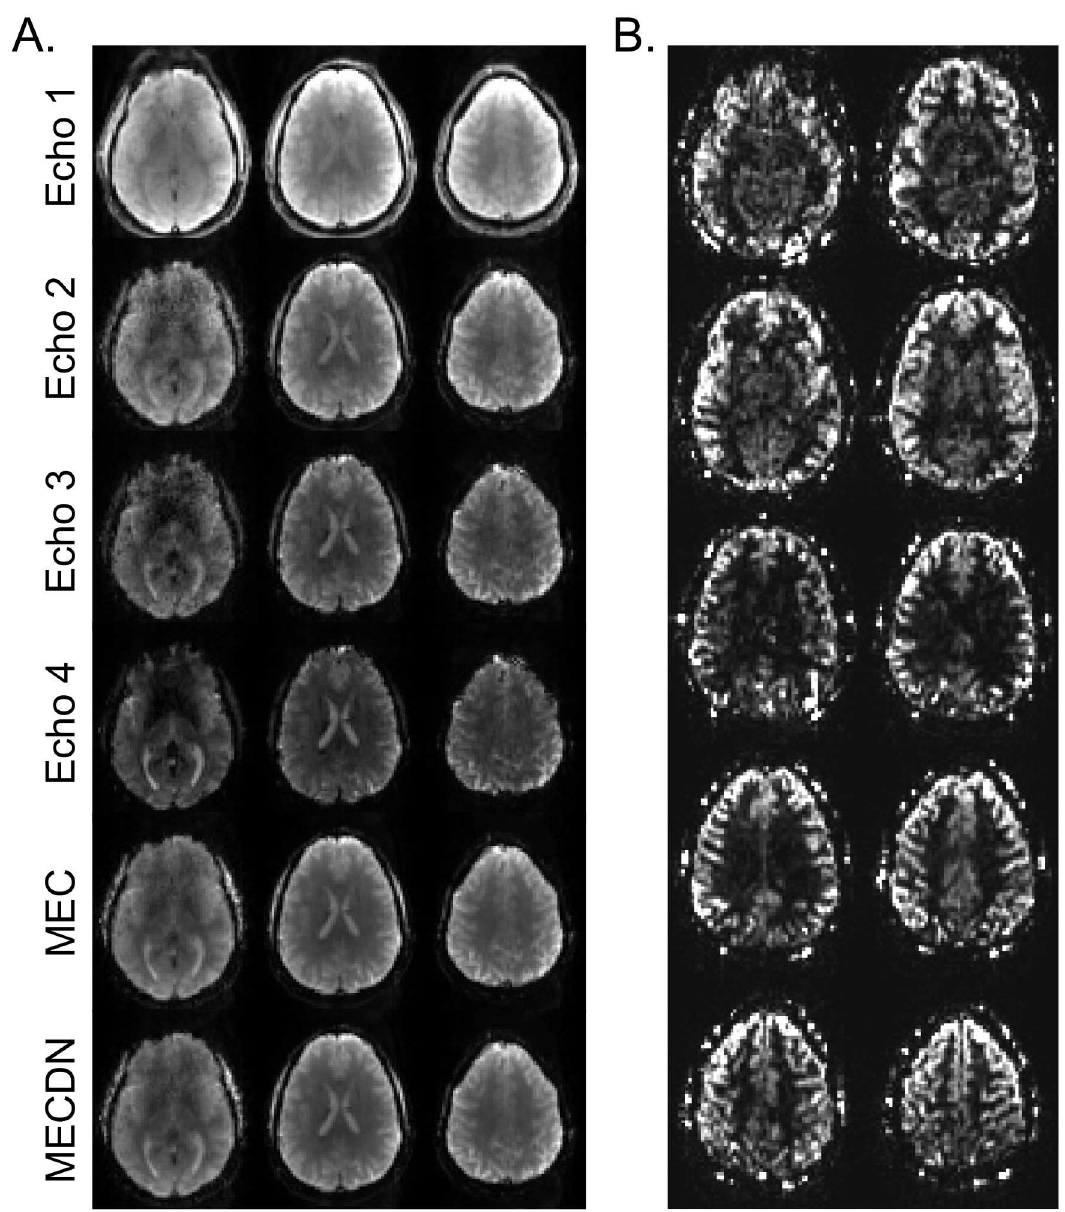
Fig 3. Representative perfusion-weighted, individual echo, and multi-echo images. (A) Exampleindividual echo, MEC, and MECDN images from one subject. Image SNR decreases with echo time. Image qualityimproves with echo combination and signal in the inferior portionsof the brain is recovered. All images share the same color scale. (B) Perfusion weightedimages. Images were producedby averaging and subtractingthe label images from the control images. High-resolution whole-brainimages were collectedin a relativelyshort amount of time with reducedsignal loss caused by T1-relaxtionof the labeledblood.